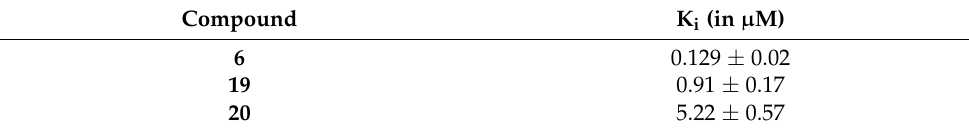
Table 2. K i values (in µ M) for conjugates 6 , 19, and 20